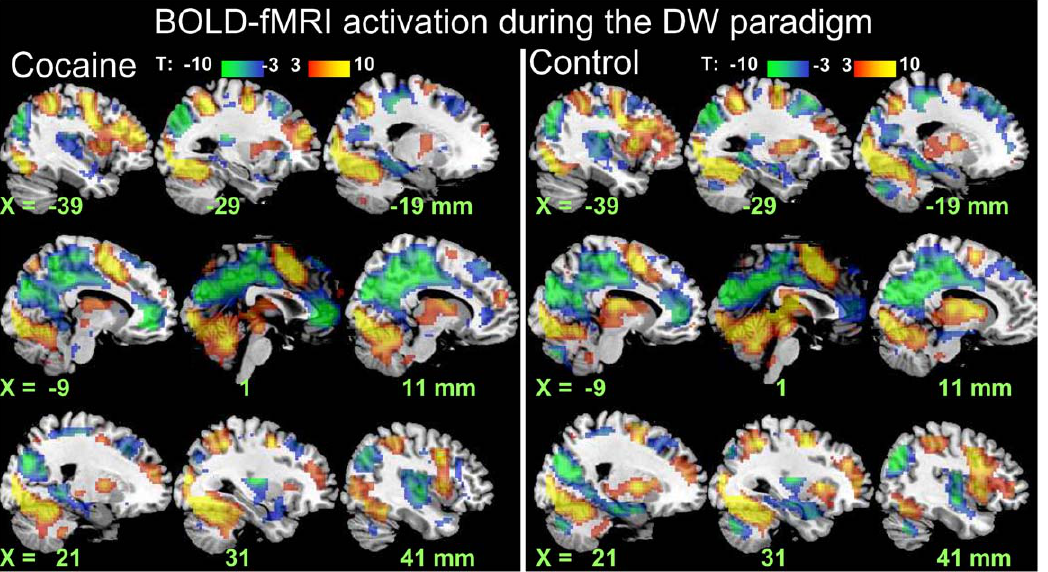
Figure 4. Brain activation. Statistical maps of BOLD-fMRI signals during the DW task across word conditions (‘‘Drug’’ and ‘‘Neutral’’) for 20 cocaine abusers (left) and 20 healthy matched control subjects (right). Random-effects analyses (two-way repeated measures ANOVA). Red-yellow and blue- green color bars show the t -score windows for activation and deactivation, respectively.